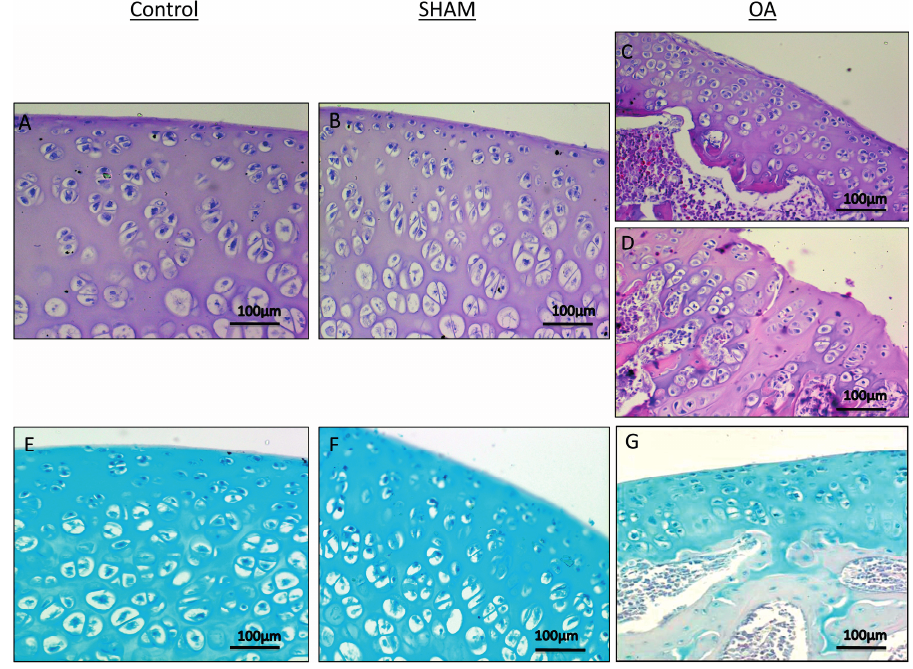
clefts, disappearance of cells from the tangential zone, chondrocyte cloning, and loss of cells in the intermediate and radial zone, which are not arranged in columns. The tidemark is no longer intact and the subchondral bone shows signs of remodeling fibrillation (Figure 2D). The toluidine blue staining was also reduced, thus indicating loss of proteoglycans and reduction of GAG content (Figure 2G). Moreover, while the surface of healthy hyaline cartilage appeared white, shiny, elastic and firm, in OA the surface was dull and irregular.